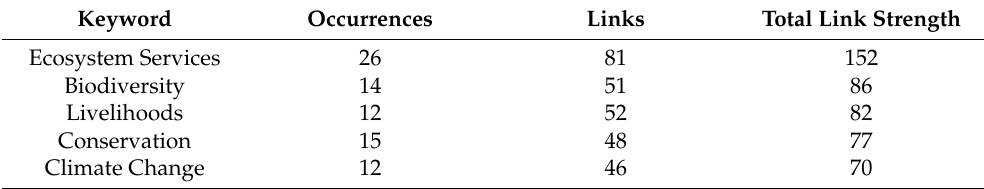
Figure 5. Co-occurrence network map of keywords from qualitative ES assessments for southern Africa published in 1996–2021. Table 4. Top 5 most occurring keywords in qualitative studies according to total link